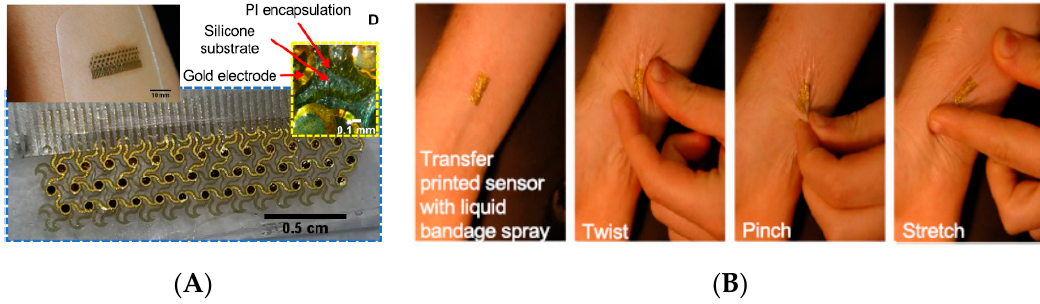
Figure 1 . ( A ) Image of the gold electrodes array on a polymeric wound dressing. ( B ) Pictures of a transferred printed flexible array, fixed with a liquid bandage, under mechanical stress. Reproduced from [27] with permission. Copyright 2019 Elsevier B.V.